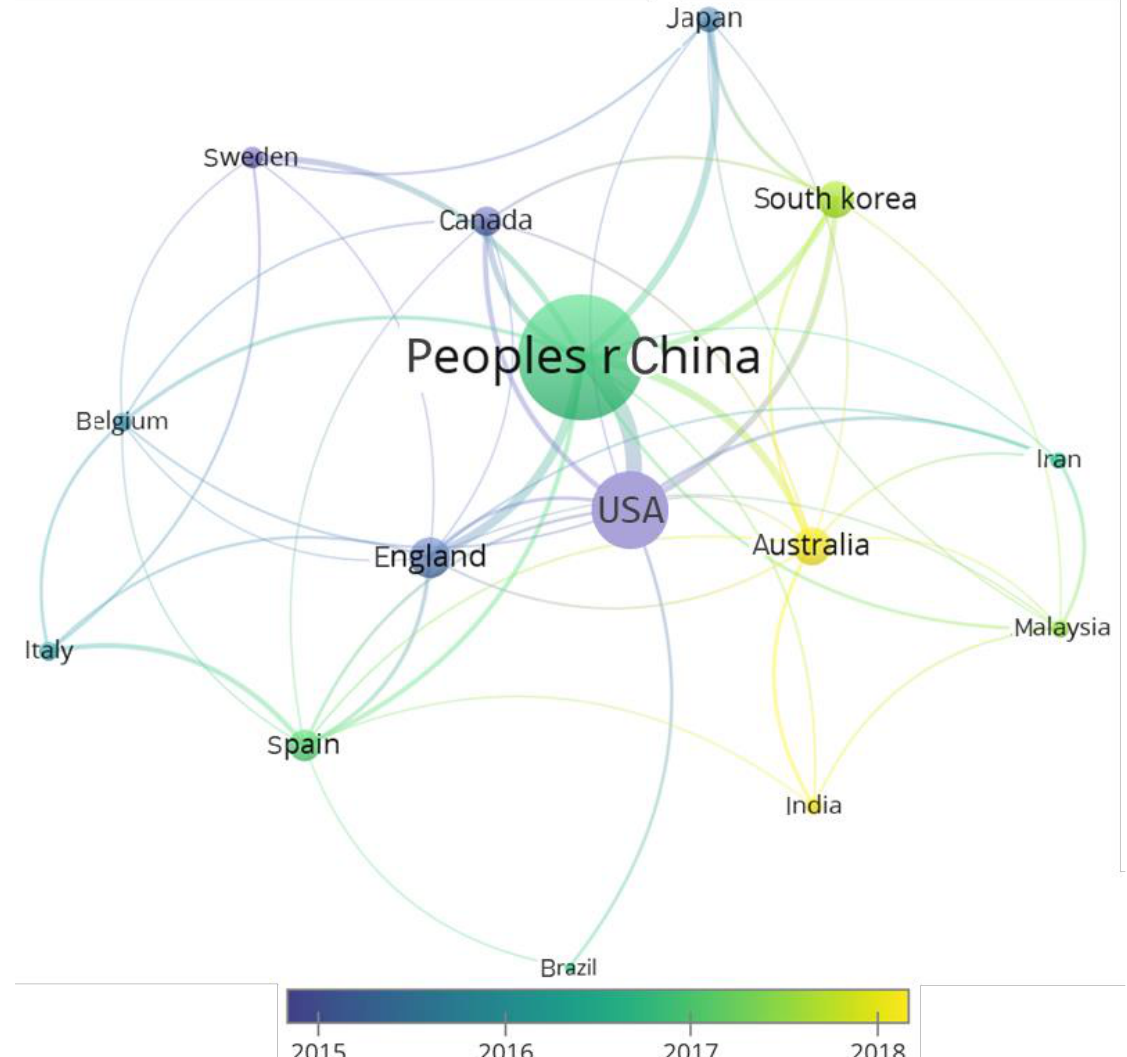
Figure 4. Cooperation network among countries in the research field of steel slag. Figure 6 manifests that the H-index and CPP have a consistent pattern for